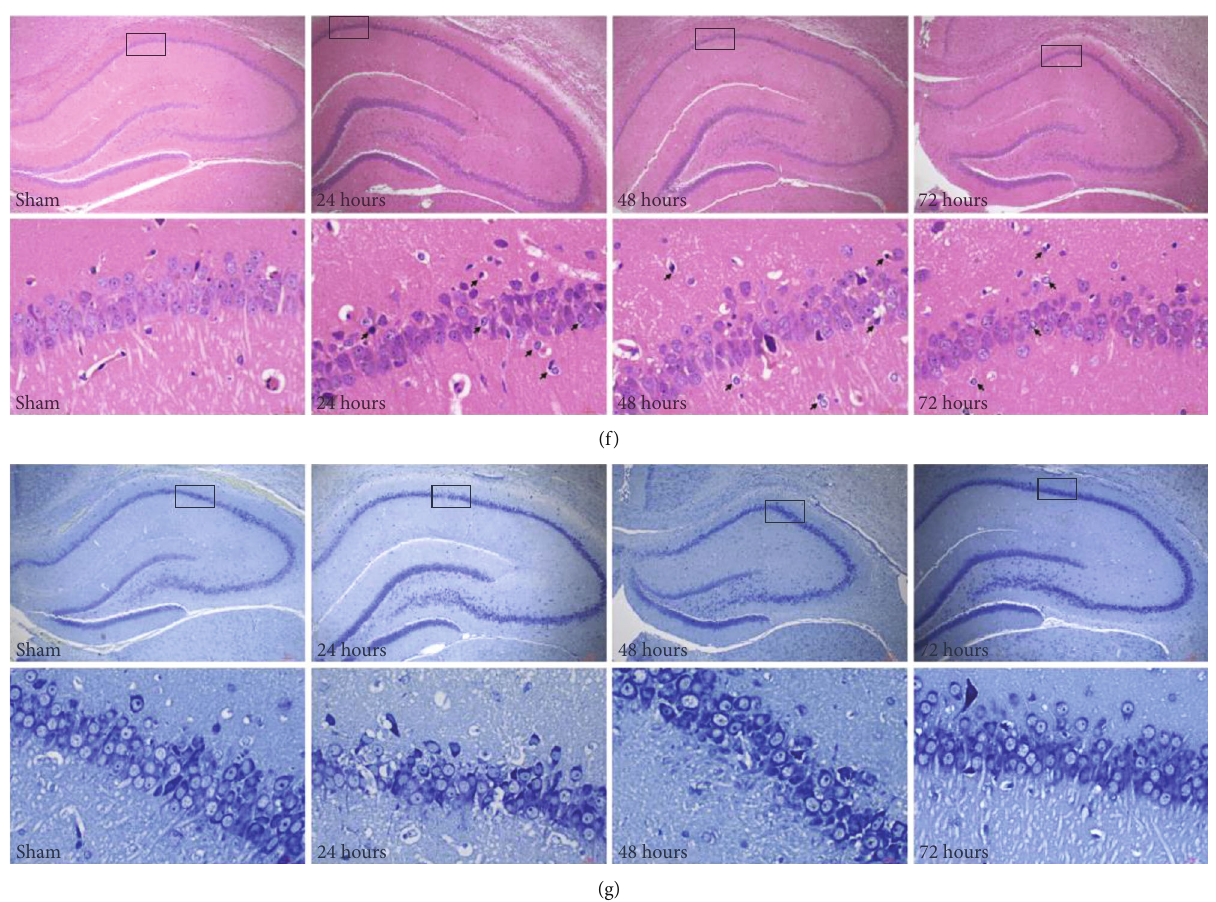
Figure 1: CI/R caused behavior de fi cits, cerebral ischemic lesion, and neuronal death in the rat MCAO model. Rats were treated with MCAO. (a) CI/R injured the gait of rats. Representative footprints of the rats are shown in each group. (b) The quanti fi cation of gait stride length (mm) ( n = 9 ). (c) Neurological severity scores of each group evaluated after reperfusion ( n = 9 ). (d) Cerebral ischemic lesion volume was detected by TTC, representative TTC-stained brain sections showing areas of healthy tissue (red) and ischemic injury (white) in di ff erent groups ( n = 6 ). (e) Quantitative analysis of ischemic lesion volume ( n = 6 ). (f) Haematoxylin-eosin (H&E) staining of the rat brain slices of each group in the hippocampal CA1 region ( n = 3 ). (g) Nissl-stained sections indicated that C/IR increased neuronal death in the hippocampal CA1 region of rats ( n = 3 ). Each bar represents the mean ± SEM . p > 0 : 05 , ∗ p < 0 : 05 , ∗∗ p < 0 : 01 , and ∗∗∗ p < 0 : 001 were statistically signi fi